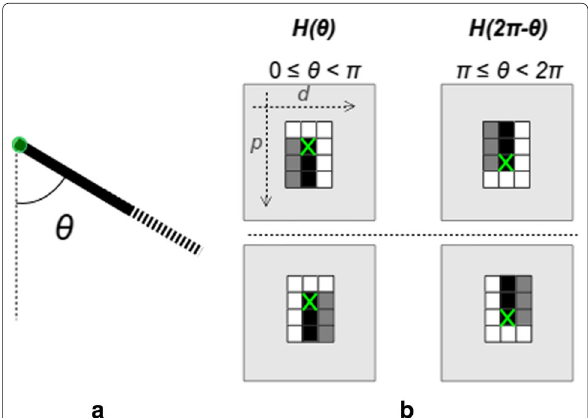
Fig. 5 Relation between a non-intersection segment endpoint in the image space and its representation in the 3D Hough space. a Non-intersection segment endpoint in the image space (endpoint position is represented by a green circle). b Representation of an image endpoint in the 3D Hough space. Cells associated with the endpoint are marked with a green